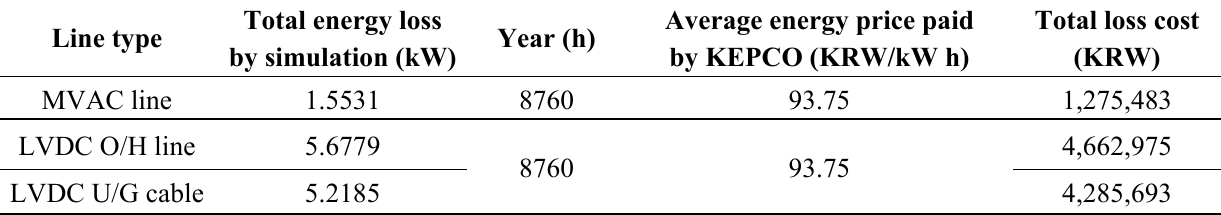
Table 5. Energy loss costs of MVAC and LVDC.